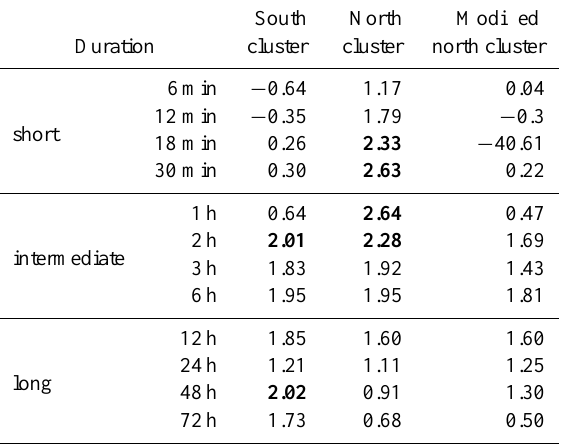
Table 3. Values for the homogeneity measure H 1 for south and north cluster (original and modified to improve homogeneity). Val- ues above 2 (“definitely heterogeneous”) are highlighted in